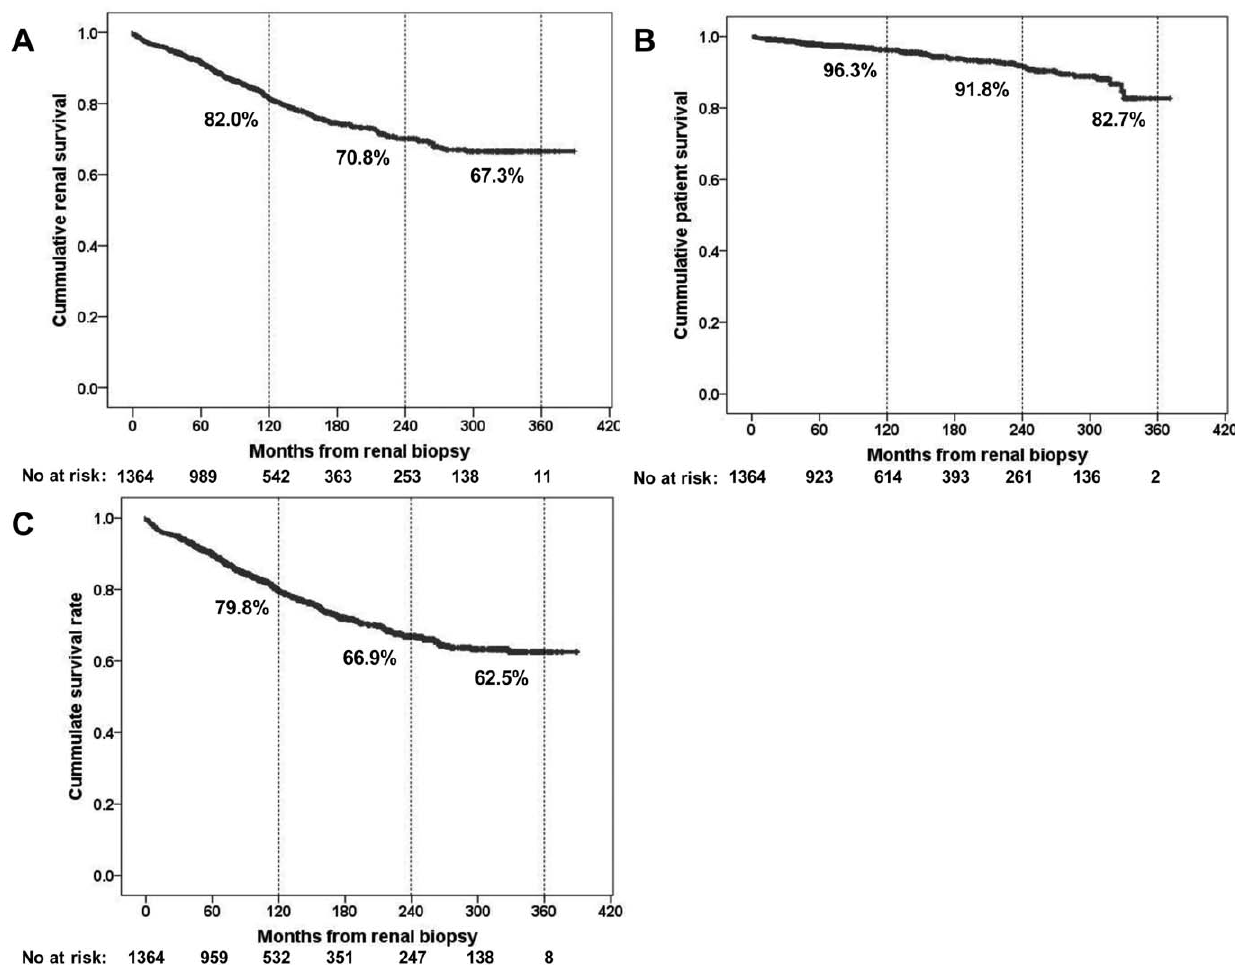
Figure 1. Cumulative renal and patient survival after renal biopsy. The primary endpoint was renal (A) and patient survival (B) and composite outcome (C). The numbers of patients remaining at 60, 120, 180, 240, 300, and 360 months of follow-up are shown at the bottom. ESRD, end stage renal disease.